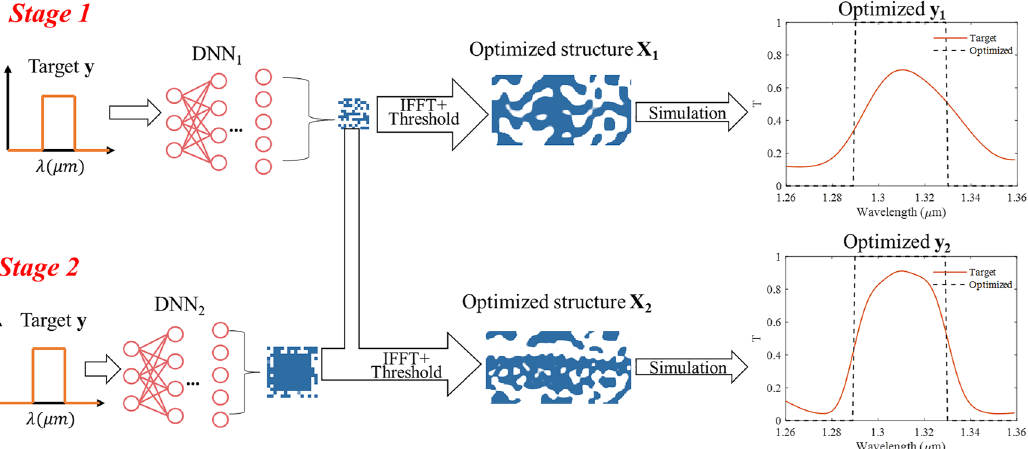
Figure 8: Schematic of multi-stage optimization procedure. In stage 1, the optical target is mapped to the low-frequency components in fourier space by a simple DNN pictures show the optimized structures X